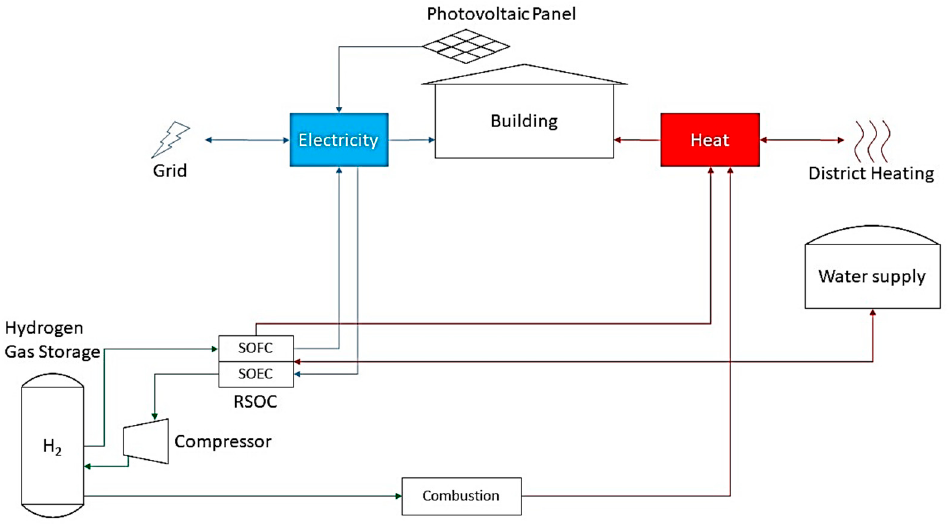
Figure 3. The reversible solid oxide cell and hydrogen storage system (RSOCHS).